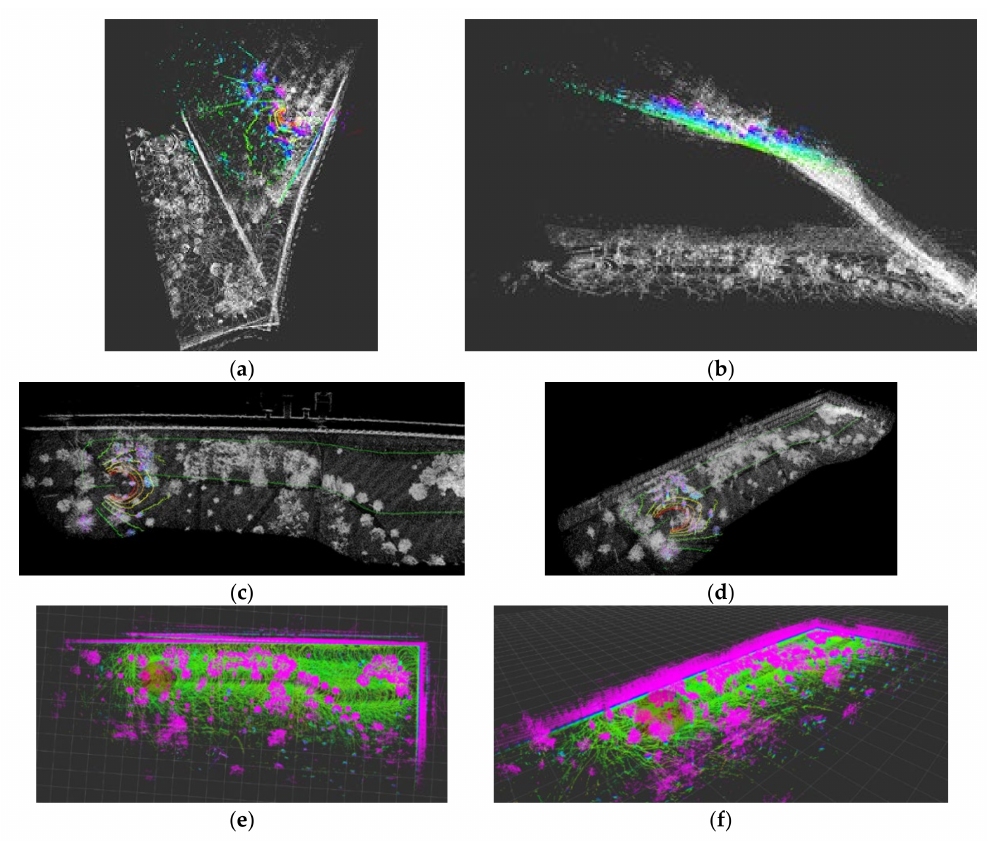
Figure 4. Results of the SLAM algorithms for an outdoor environment: ( a ) top view of LOAM results; ( b ) side view of LOAM results; ( c ) top view of A-LOAM result; ( d ) perspective view of A-LOAM results; ( e ) top view of HDL Graph SLAM results; ( f ) perspective view of HDL Graph SLAM